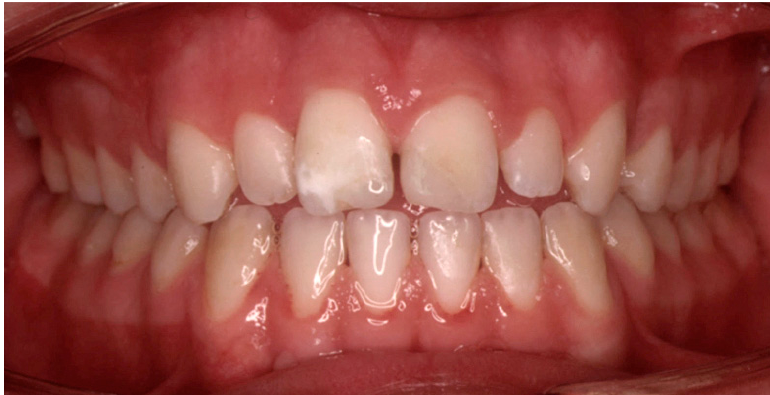
Figure 4. Intraoral view when the splint was removed (three weeks after injury).